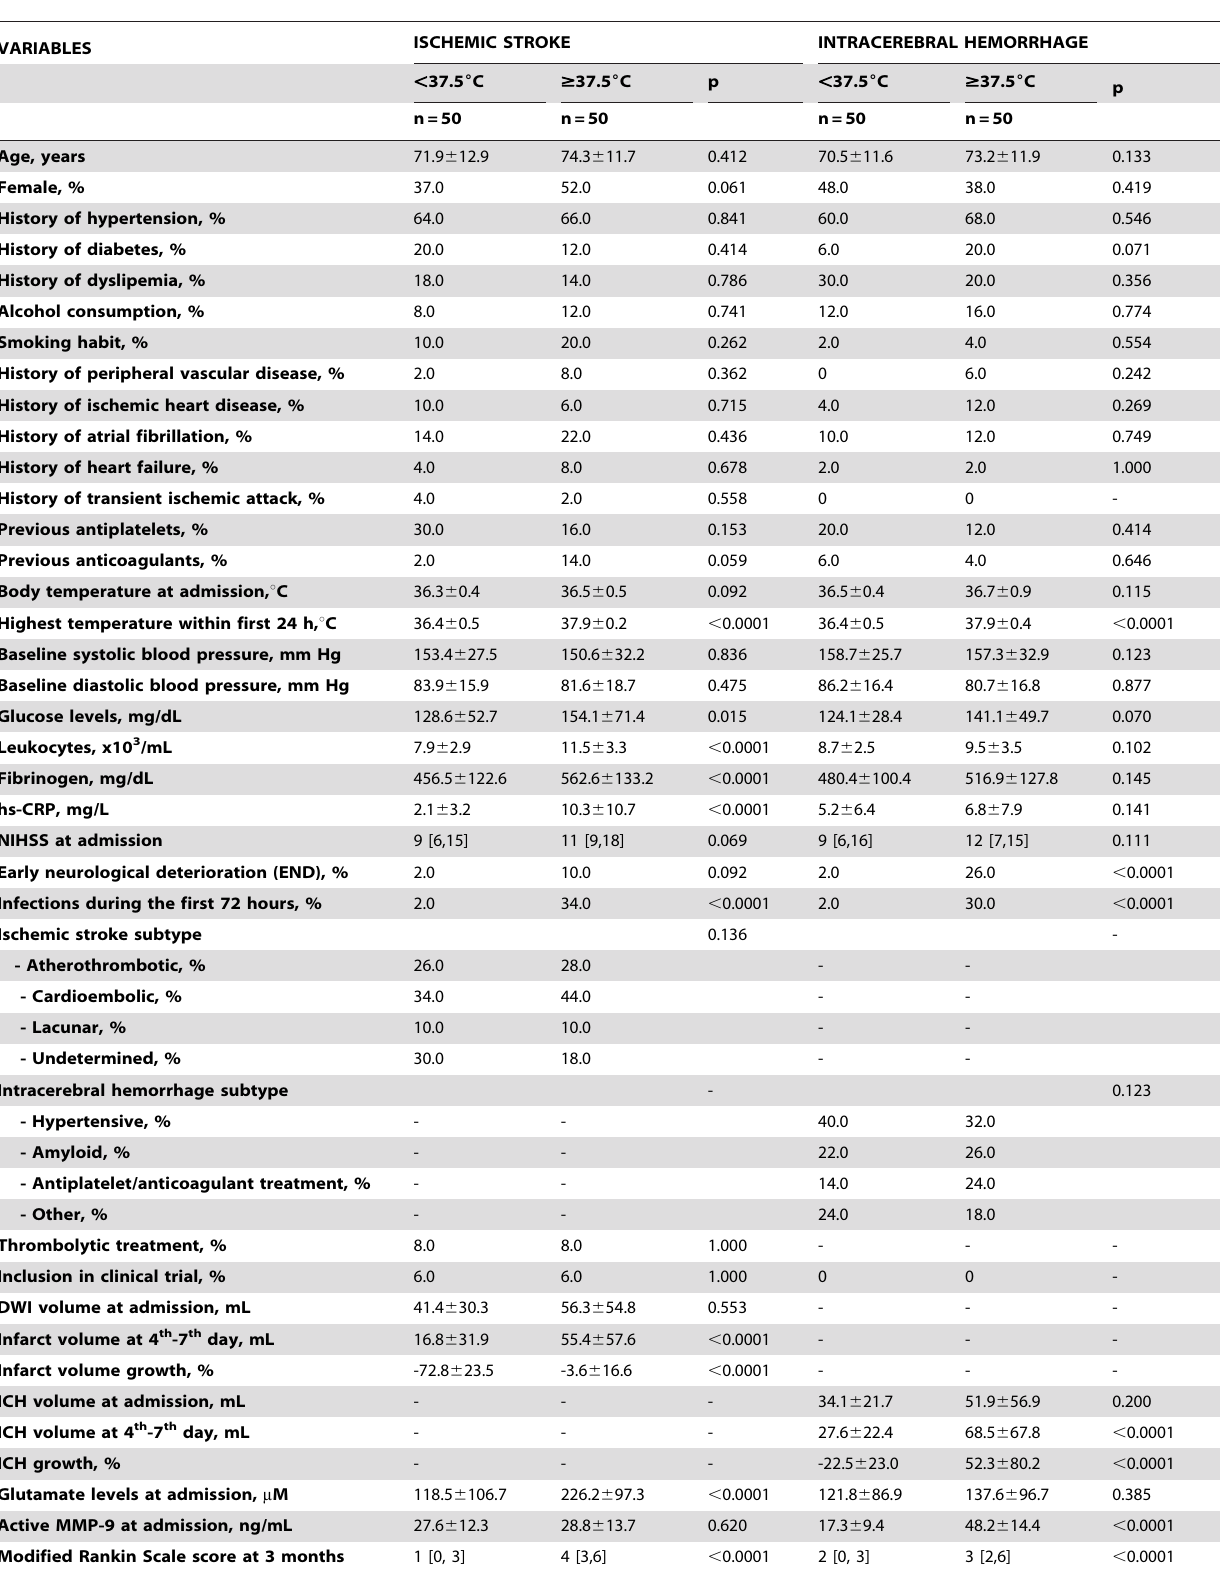
Table 1. Clinical, biochemical and neuroimaging characteristics of ischemic and hemorrhagic stroke patients according to the cutoff of point of , 37.5 u C or $ 37.5 u C for the highest body temperature within the first 24